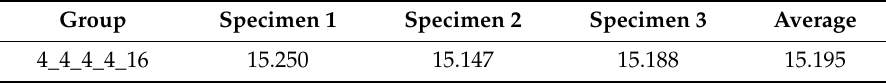
Table 7. The tests result of static tensile failure load F b (kN).